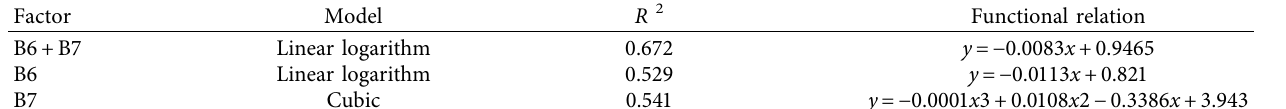
Table 9: Fitting model of NH